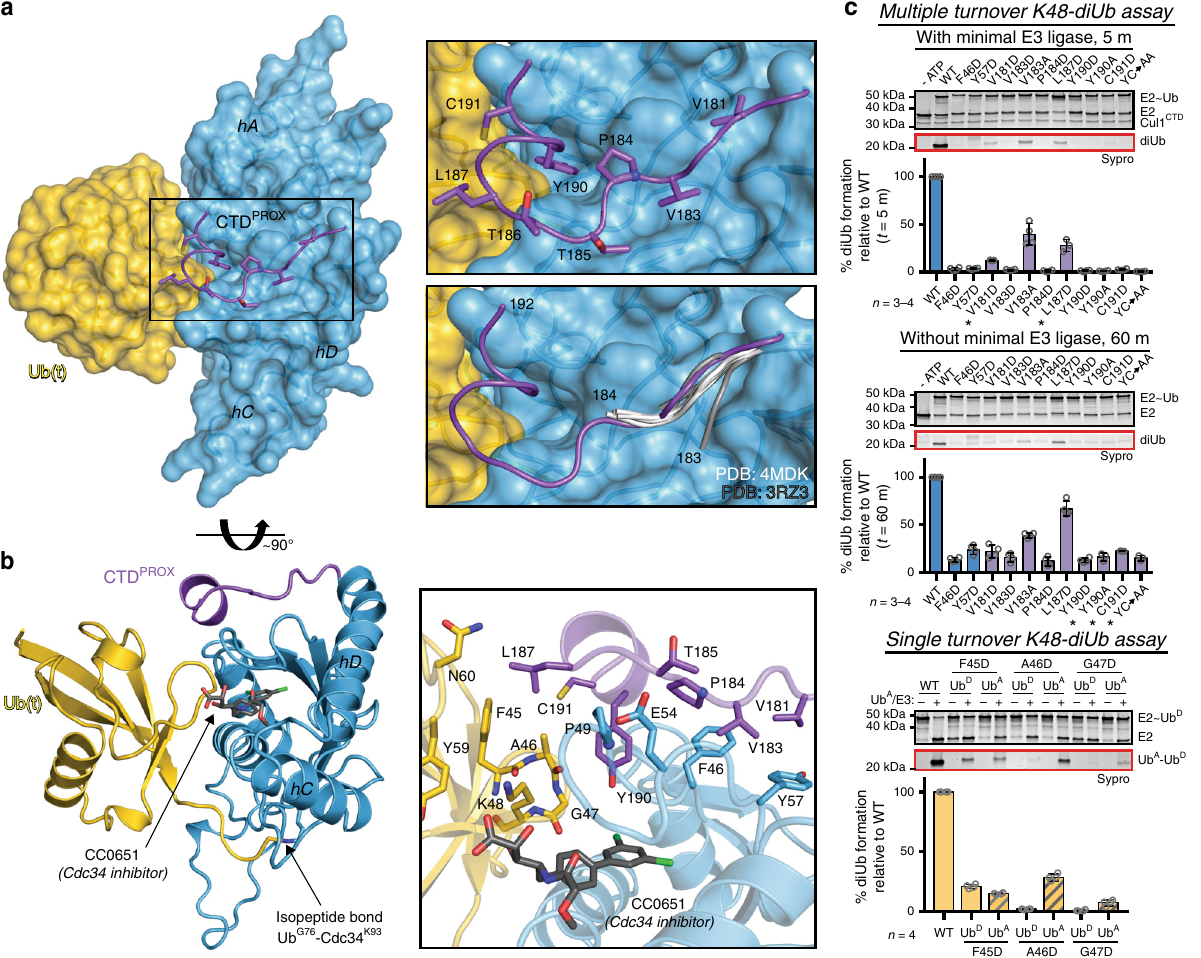
Fig. 6 An ordered Cdc34 CTD prox extension is involved in Ub discharge. a Left , crystal structure of hCdc34B Δ dist conjugated to Ub (gold) at active site Cys to Lys mutation in presence of CC0651 inhibitor, shown as in Fig. 5c but rotated 90°. Top right , zoomed in view of Cdc34 CTD prox trajectory over the Ubc core with contacting residues shown as sticks. Bottom right , zoomed in view of CTD prox as in Fig. 5c. b Left , cartoon representation of hCdc34B Δ dist -Ub as in a but rotated ~90° with CC0651 shown as gray sticks and isopeptide bond indicated. Right , zoomed in view of Cdc34 CTD prox , Ubc core, and Ub(t) interfaces with contacting residues shown as sticks. c K48-diUb assays for the indicated mutants with ( top ) and without ( middle ) minimal E3 ligase. Data are represented by mean ± SD with individual replicates shown as gray circles. Biochemical assays have four independent replicates, unless indicated by an asterisk when there are three replicates. Representative replicates are labeled above. Bottom , single turnover K48-diUb assay with indicated Ub mutants ( n = 4). Data are shown as above with representative image labeled above with ( − ) lanes to show initial thioester formation and ( + ) to indicate subsequent addition of E3 ligase and excess Ub A for single Ub discharge. Source data are provided as a Source Data fi